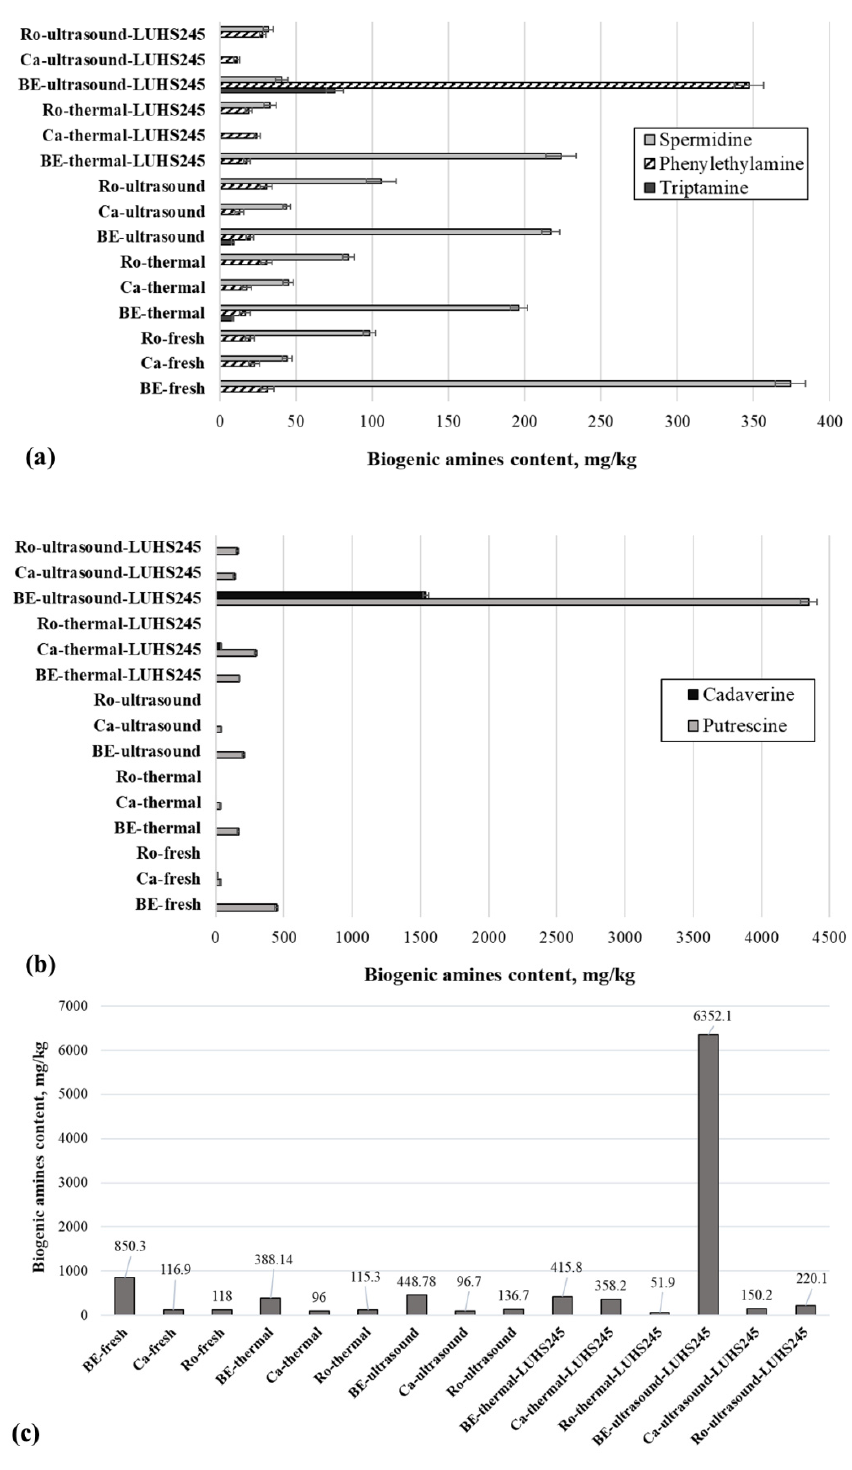
Figure 5. ( a ) The content of spermidine, phenylethylamine, and triptamine in edible mushrooms; ( b ) the content of cadaverine and putrescine in edible mushrooms; and ( c ) the sum of biogenic amines in edible mushrooms (BE— Boletus edulis ; Ca— Cantharellus cibarius ; Ro— Rozites caperata ; thermal—thermally treated by boiling for 30 min; ultrasound—ultrasonicated for 30 min; LUHS245—fermented with L. uvarum LUHS245).